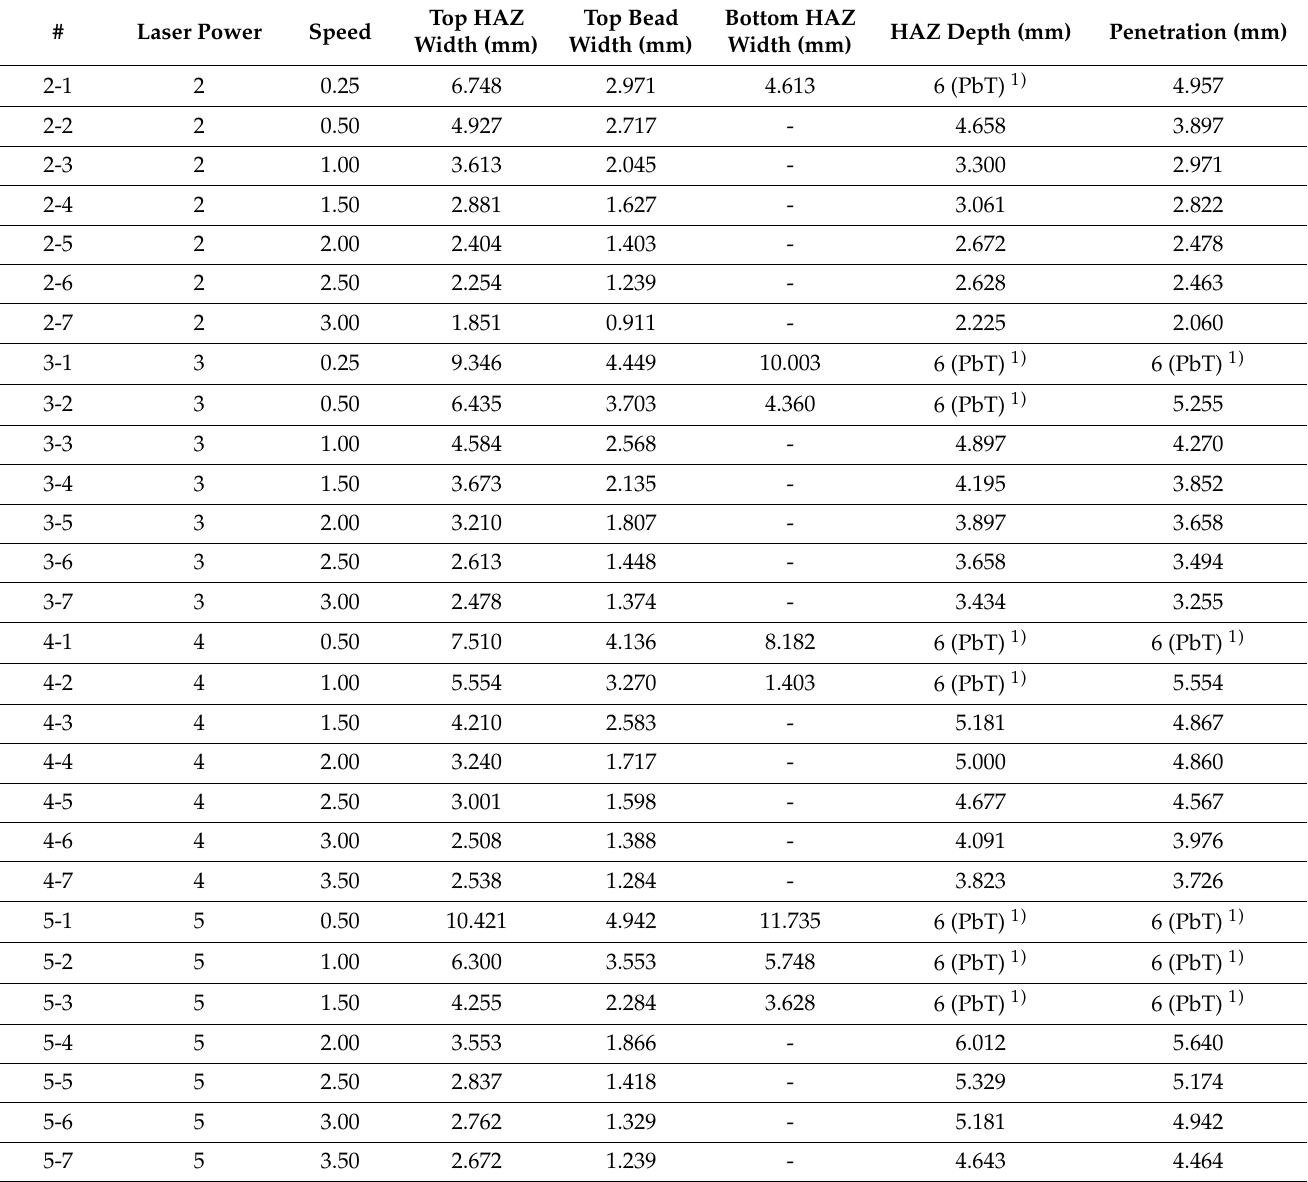
Table 4. Results of BOP